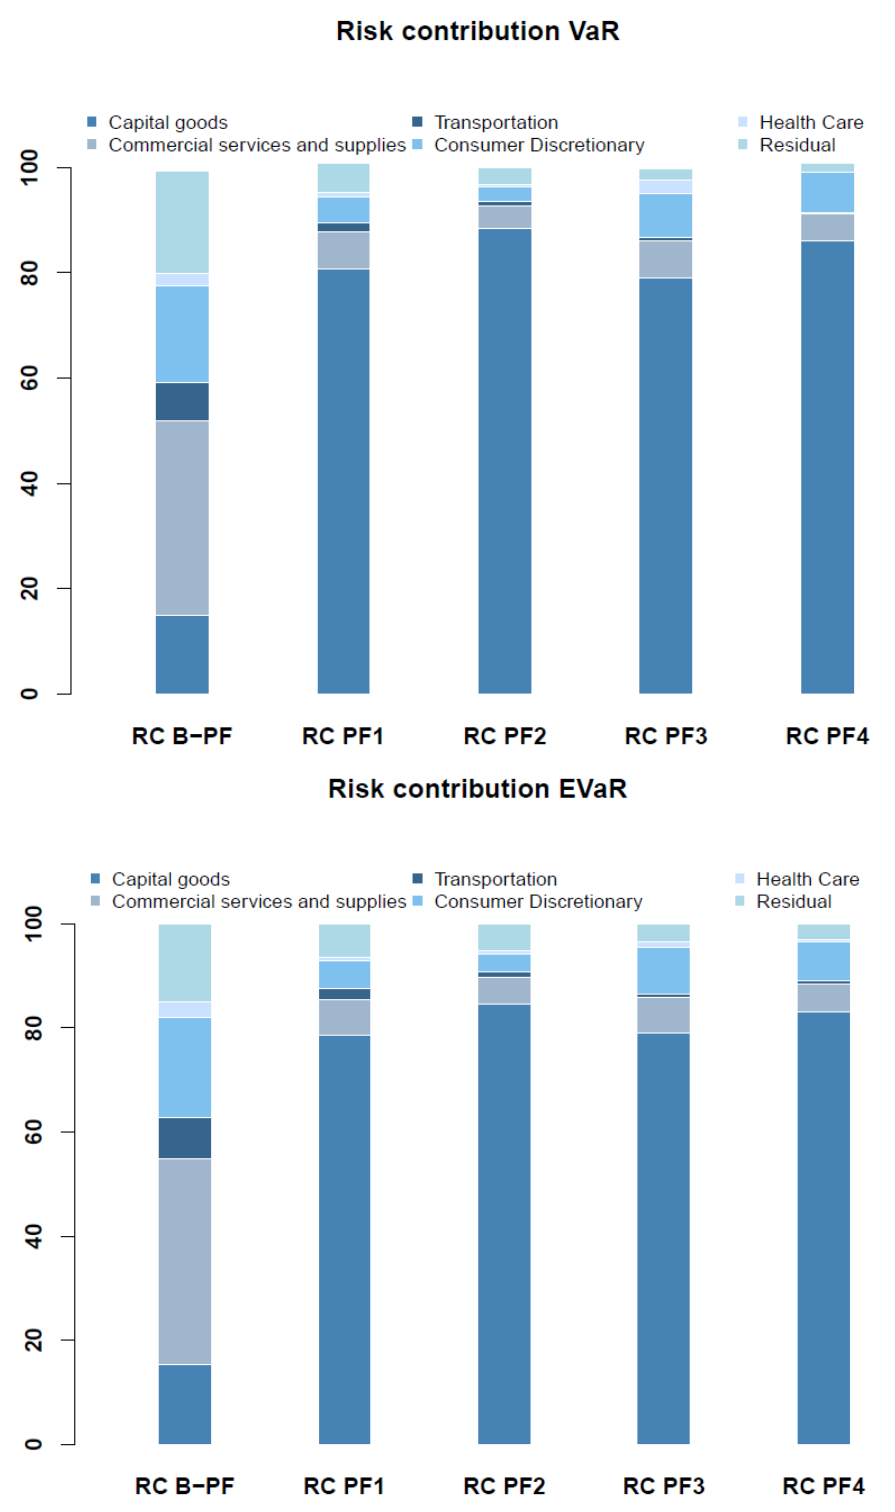
Figure 3. Risk contribution over all